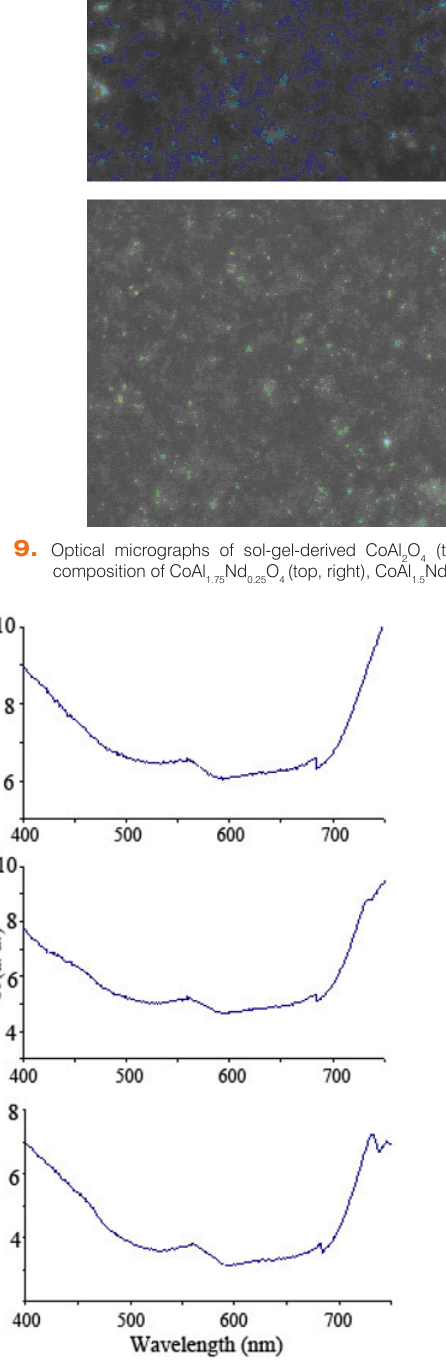
Figure 10. Optical reflectance spectra of glazes having different